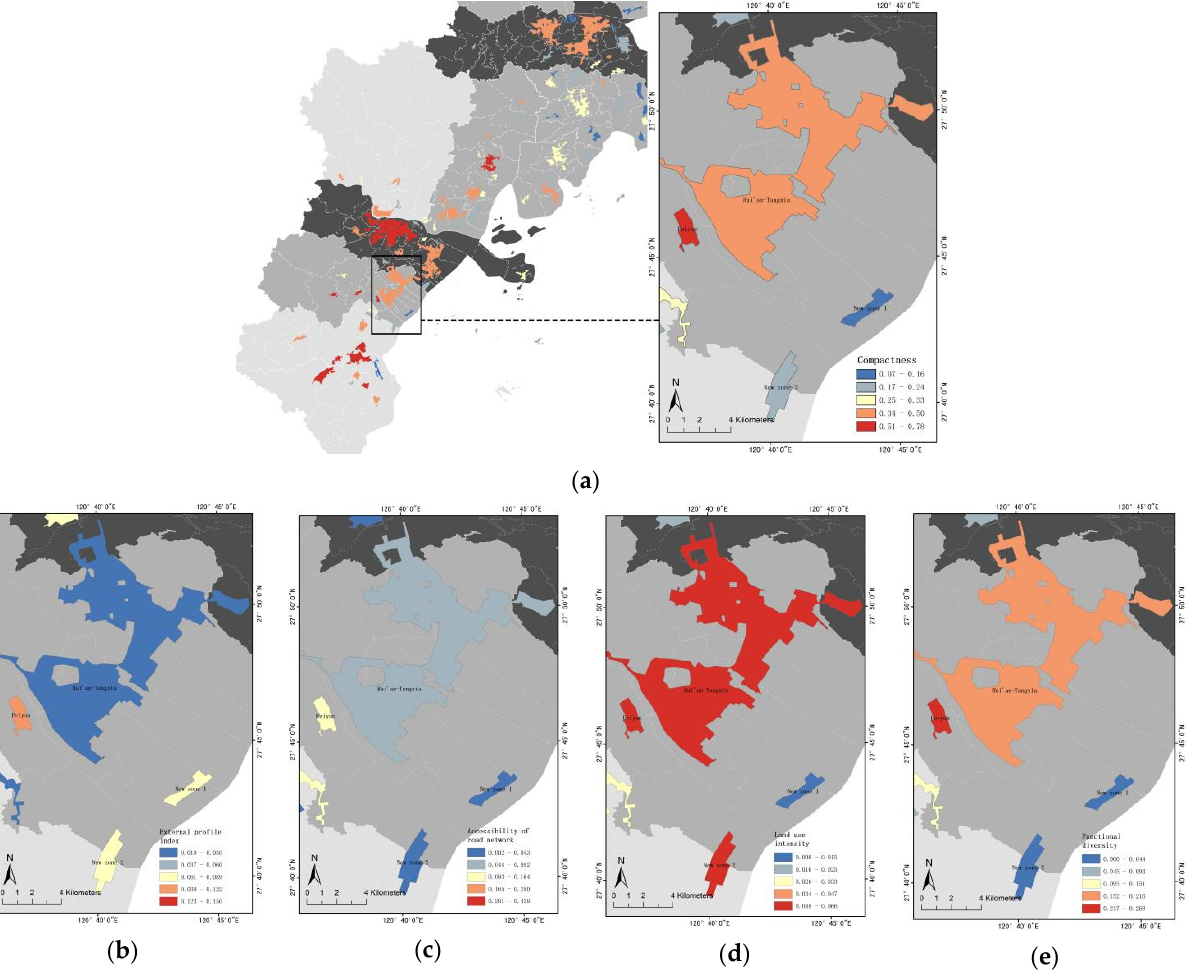
Figure 13. Differences of compact dimensions among PUAs in Rui’an: ( a ) Location and compactness; ( b ) External profile index; ( c ) Accessibility of road network; ( d ) Land use intensity; ( e ) Functional diversity.